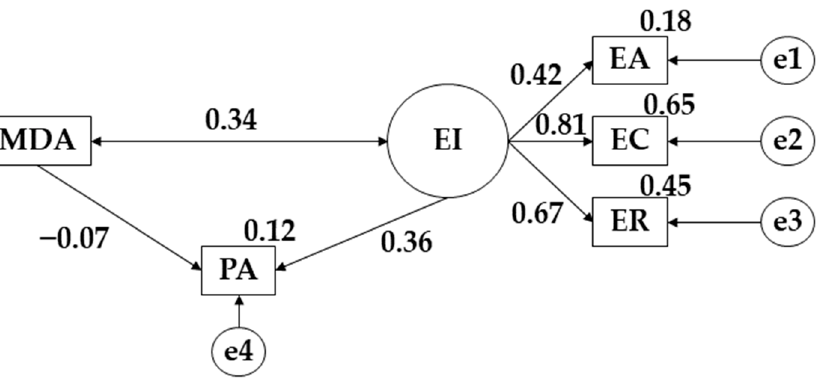
Figure 3. Model proposed for male sample. Note: emotional attention (EA); emotional clarity (EC); emotional repair (ER); Mediterranean Diet adherence (MDA); physical activity (PA).